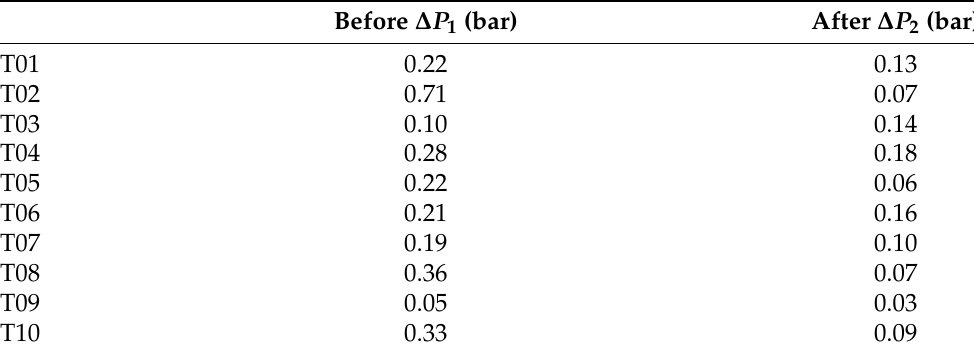
Table 1. Average values of ∆ P in the period before the gearbox maintenance on T02 ( ∆ P 1 ) and after ( ∆ P 2 ). Note that in general most of the turbines undergo a drop of pressure as a consequence of ordinary